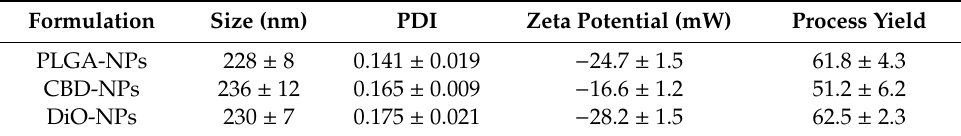
Table 2. Size, polydispersity index (PDI), zeta potential and process yield of nanoparticles. The data are themeanof4replicates( n = 4). PLGA:poly-lactic- co -glycolicacid. DiO:3,3 (cid:48) -dioctadecyloxacarbocyanine perchlorate. NPs: